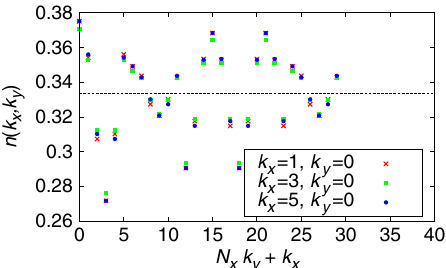
FIG. 5. Occupation number of each of the single-particle mo- mentum orbitals for the three N ¼ 10 ground states (which occur at different total momenta) at N x ¼ 5 , N y ¼ 6 . Notice that the occupation number is uniform and close to the filling factor 1 = 3